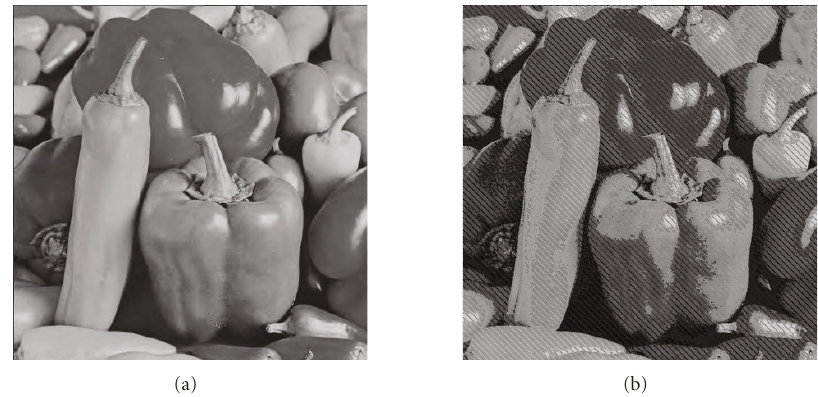
Figure 7: Reconstructed image at the bit rate of 2 . 0bpp, (a) using our method with PSNR of 32 . 61dB and (b) using CL’s method with PSNR of 20 .